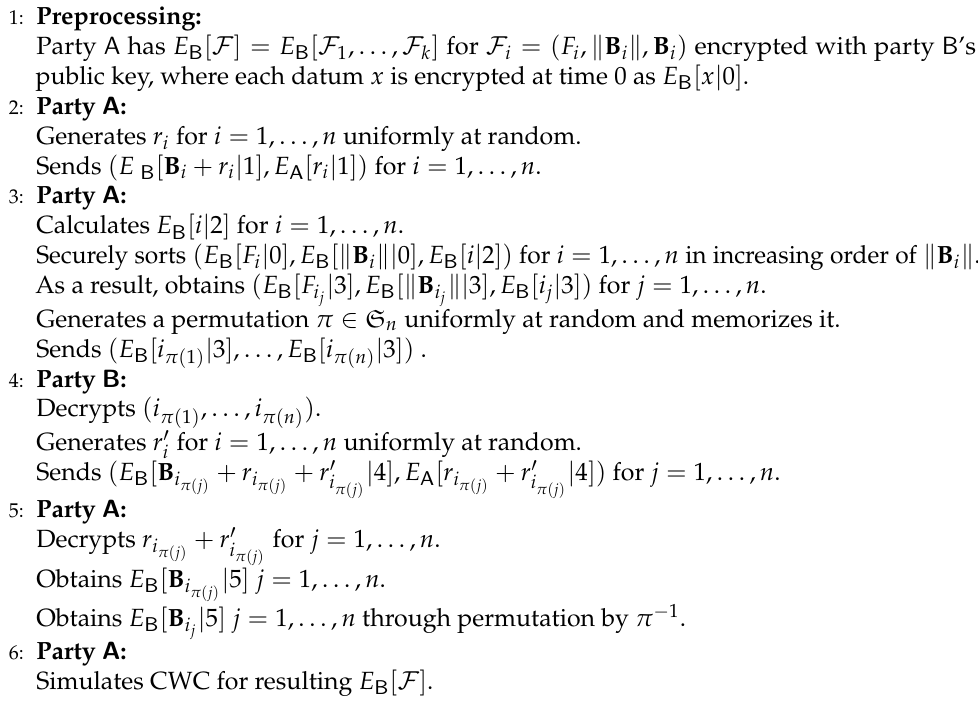
Algorithm 2 Improved secure CWC between parties A and